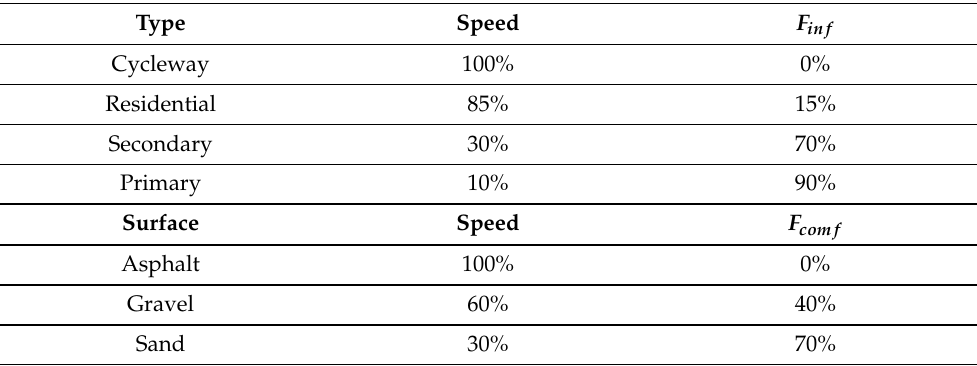
Table 3. Velocity and dis-utility